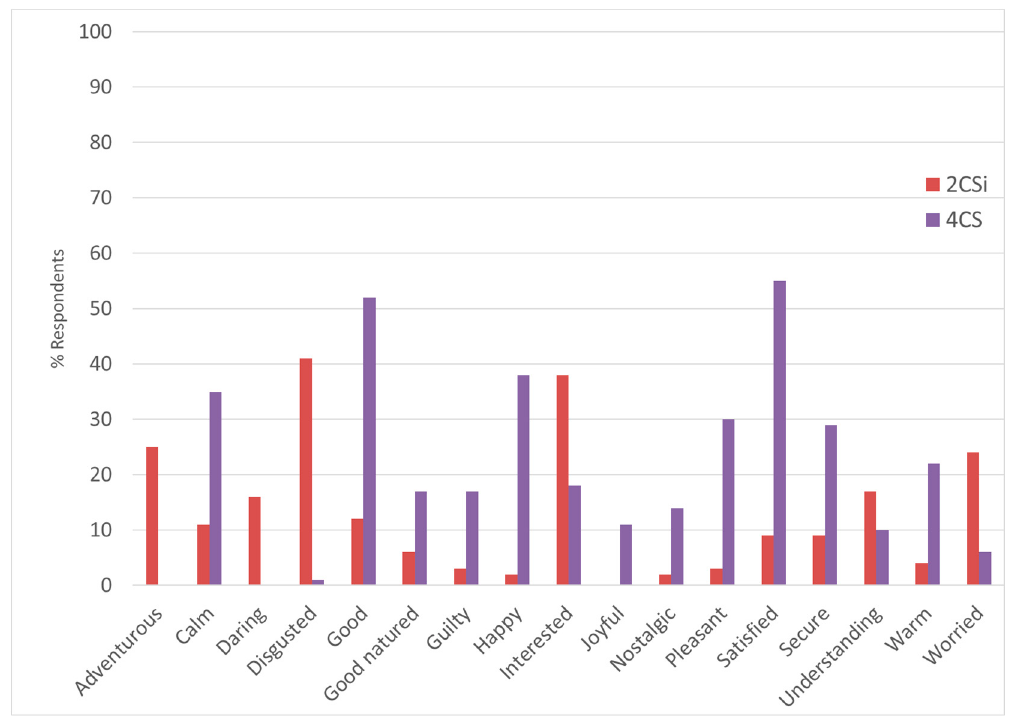
Figure 10. Estimated percentages of respondents considering all emotions and the Treatments 2CSi and 4CS. Treatment abbreviations can be found in Table 1.